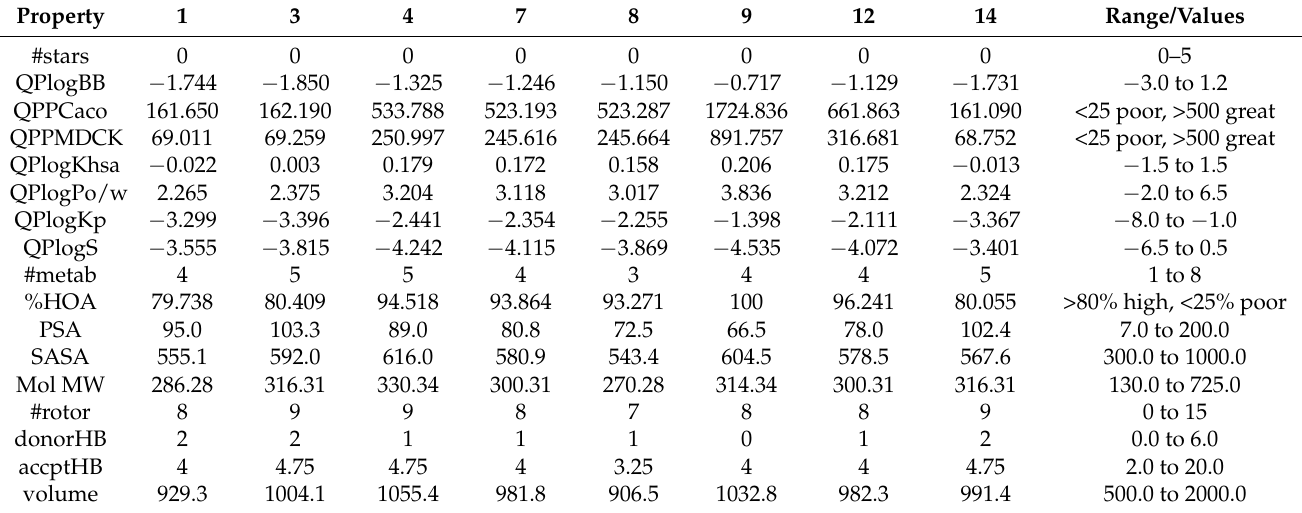
Table 5. In silico ADME profile prediction of selected flavonoids a and their range/recommended values b